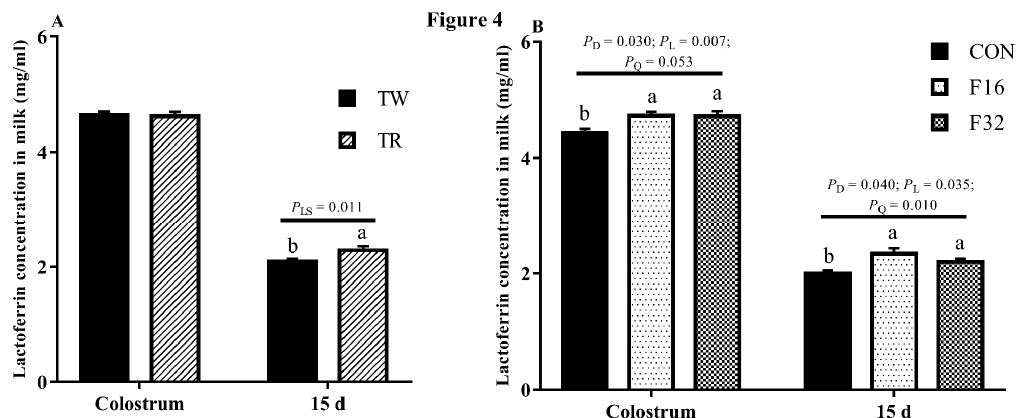
Figure 4. The concentration of lactoferrin influenced by litter size ( A ) and FA levels ( B ) in milk. Data are means ± SEM. TW, twin born; TR, triplet born; CON, F16 and F32, ewes fed 0, 16, or 32 mg · (kg.DM) − 1 FA in the basal diet, respectively. P LS , P value of litter size; P D , P value of diet FA supplementation; P L , P value of liner e ff ect; P Q , P value of quadratic e ff ect.